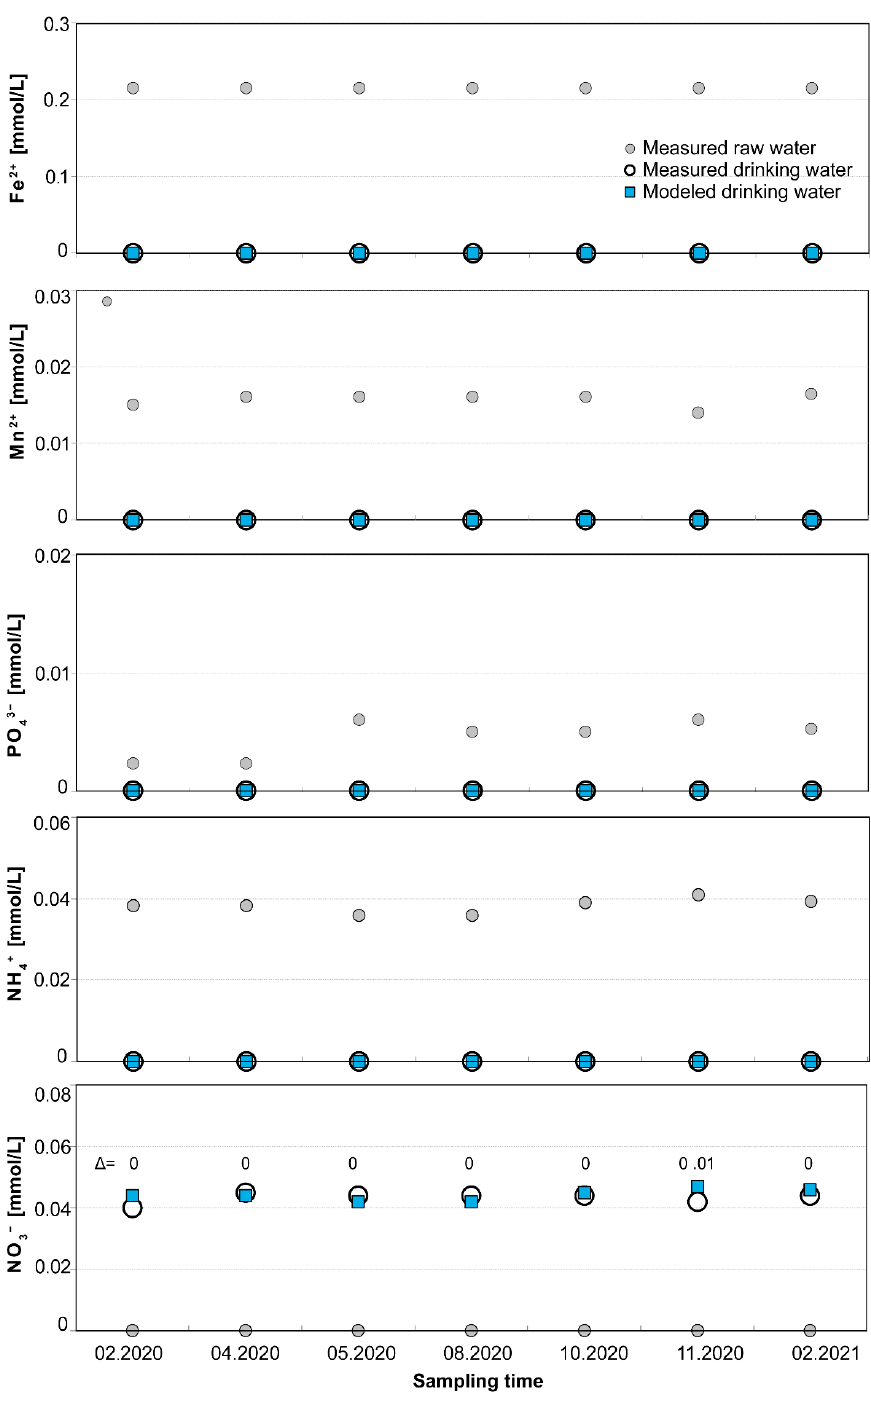
Figure 5. Comparison of the modeled values with the measured values of redox parameters; Δ = modeled value of the parameter − measured value of the parameter.